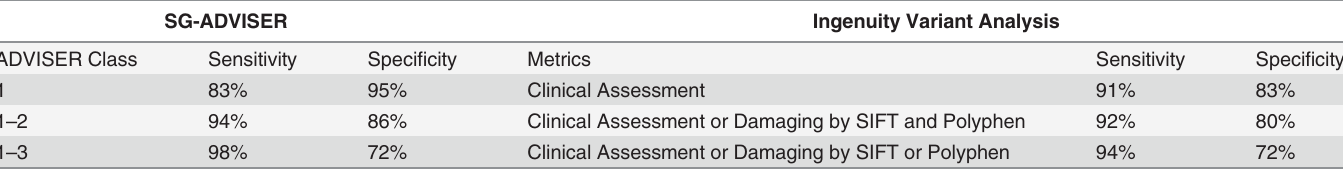
Table 1. ADVISER Class